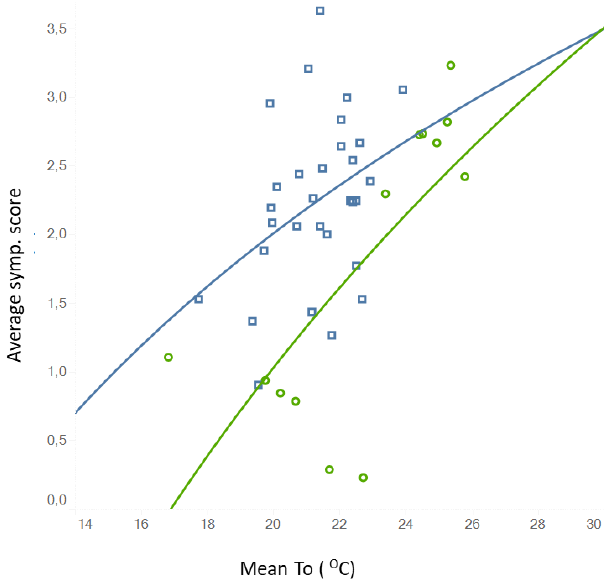
Figure 15. General average related symptoms’ scores relation with indoor operative temperature grouped by measured classrooms (green for middle season and blue for winter).